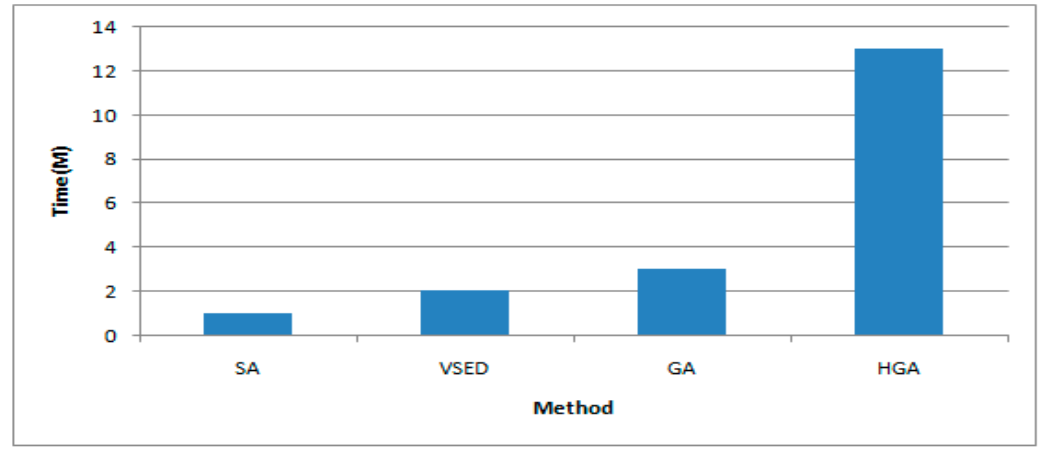
Table 7. Best result using Hybrid Genetic Algorithm (HGA).